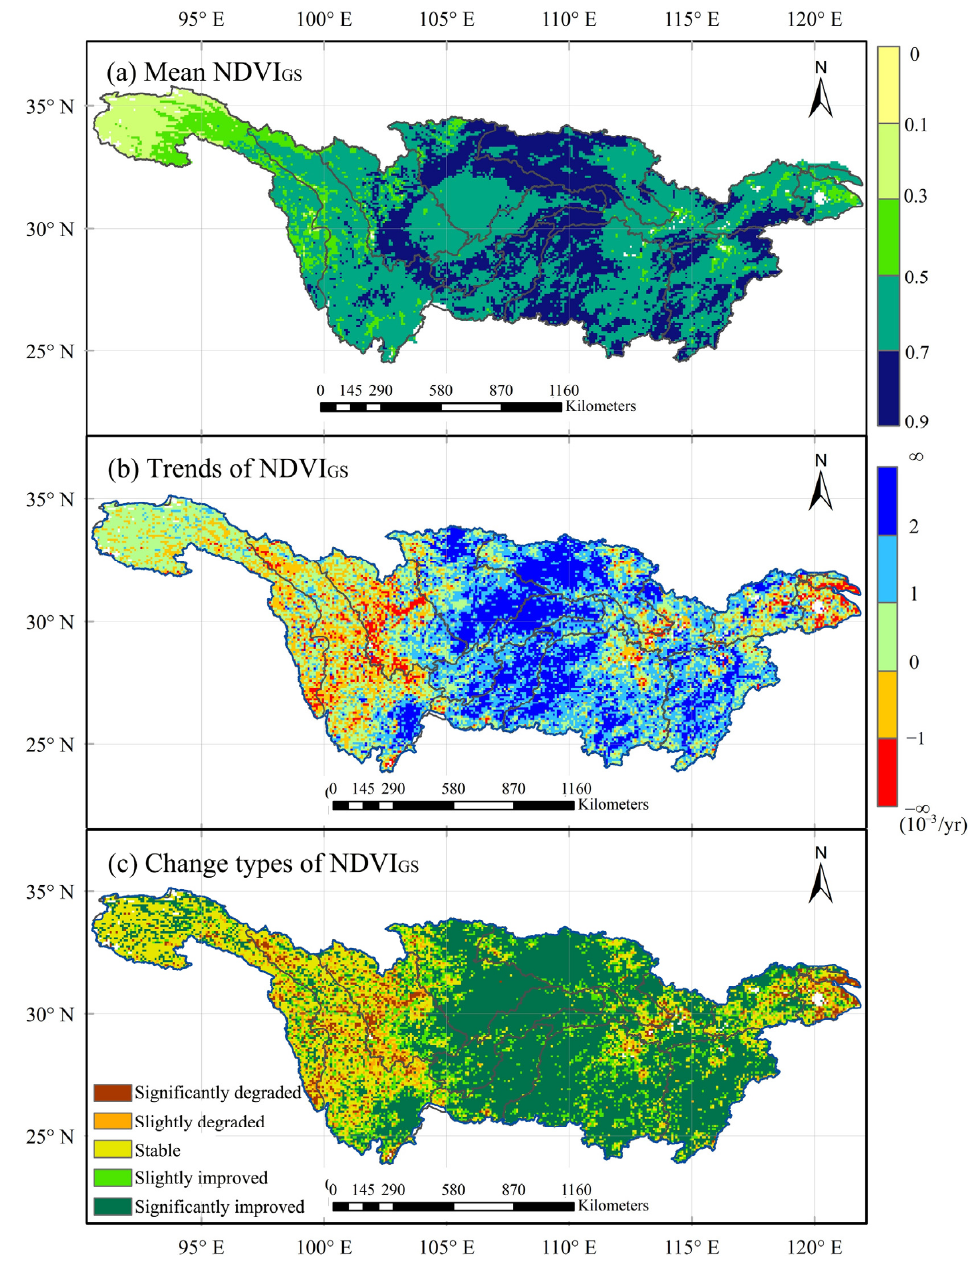
Figure 3. Spatial distributions of the ( a ) mean NDVI, ( b ) linear trends of the NDVI, and ( c ) types of NDVI changes (statistical significance) in the growing season (GS) from 1982 to 2015.